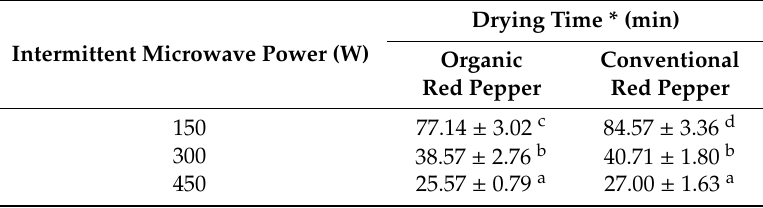
Figure 2. Change of moisture ratio in intermittent microwave drying of organic and conventional sweet red pepper shreds. Table 3. Effect of applied microwave powers on the mean drying time of organic and conventional sweet red pepper samples.